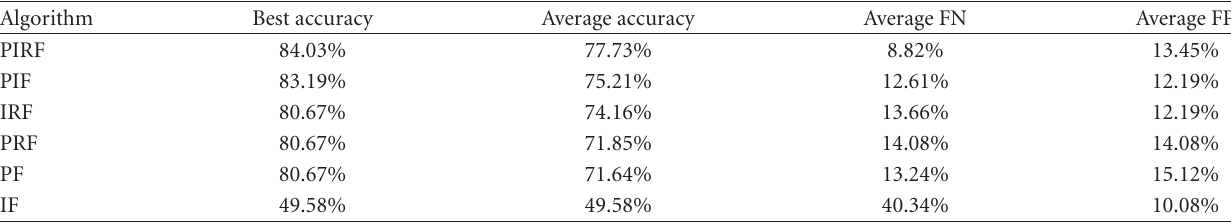
Table 4: A Comparison of the di ff erent computer-aided detection system results.